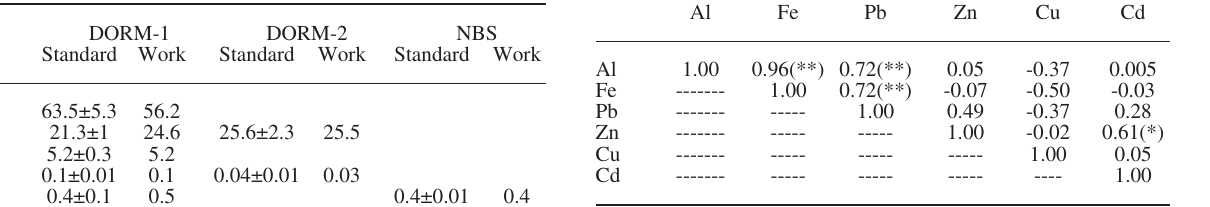
Table 3. – C ertified concentrations of Fe, Zn, cu, Pb and cd (µg g -1 d.w.) averaged over standard reference materials (DorM-1,